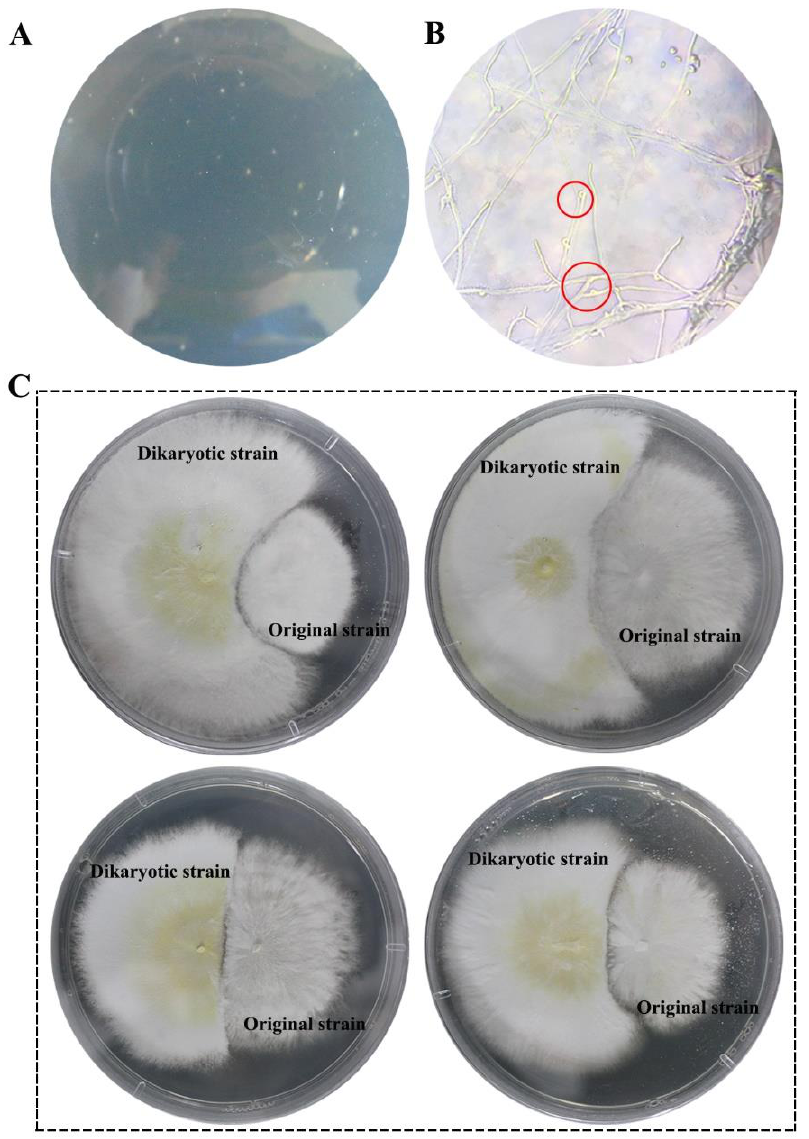
Figure 1. The acquisition and microscopy of a regenerated single colony and identification of dikaryotic mutagenic strains. ( A ): Regeneration colonies after protoplast mutagenesis of G0109; ( B ): clamp connection of regenerated dikaryotic strains; ( C ): Somatic incompatibility reaction between dikaryotic strains and original strain.